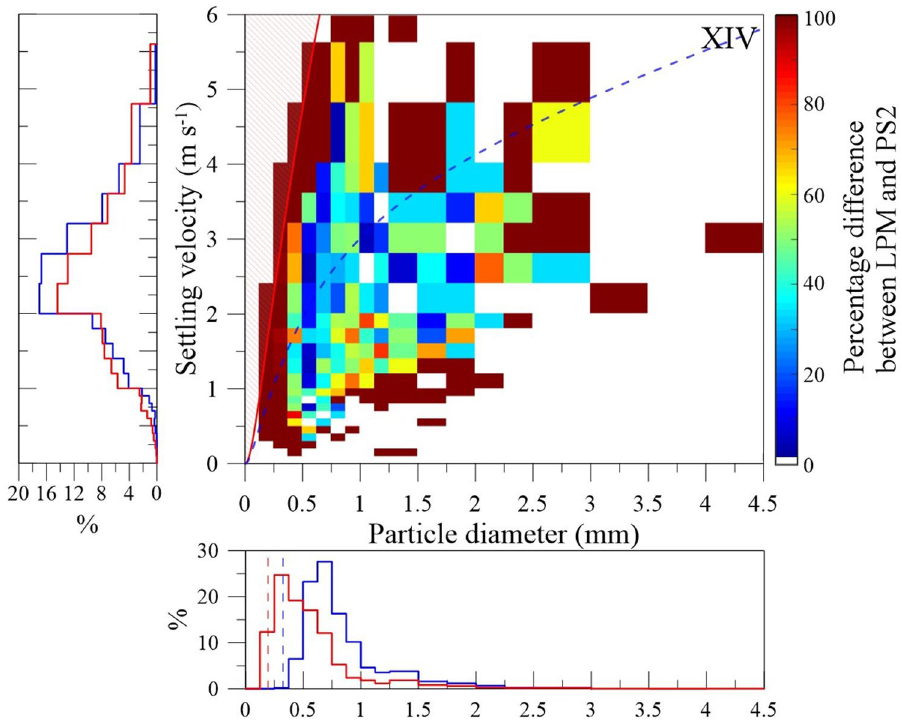
Figure 5. PSVD difference in percentage between LPM vs PS2 records of event XIV (station SVO in Fig. 1a). LPM data are reshaped following the size and velocity bins of PS2 data. Margin fallers have been corrected from LPM data. The red line indicates the trend used to filter margin fallers. The dashed blue line indicates the individual-particle trend. Left and down panels present the number percentage distributions of settling velocities and particle sizes using PS2 class widths, respectively (blue line: PS2; red line: LPM without margin fallers). All velocity and size distributions are in number frequency for a better comparison between both disdrometers. Vertical dashed blue and red lines in both down panels indicate the lower detection limits of the PS2 and the LPM,